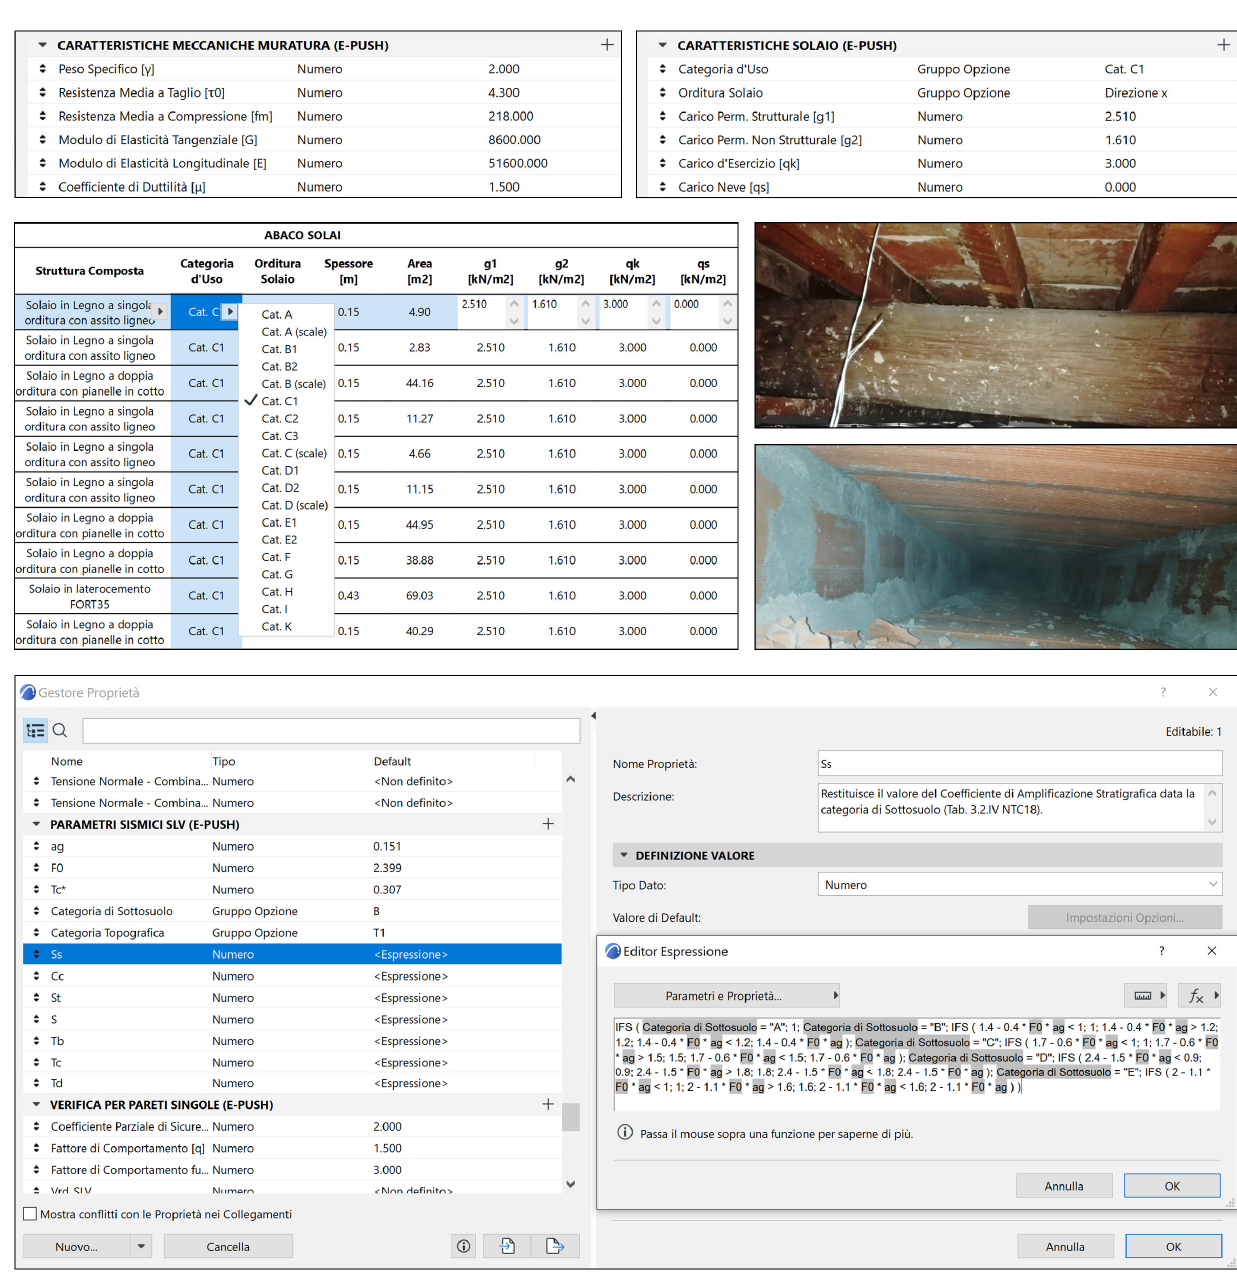
Figure 6. Loading phase in the informed structural model of the building in